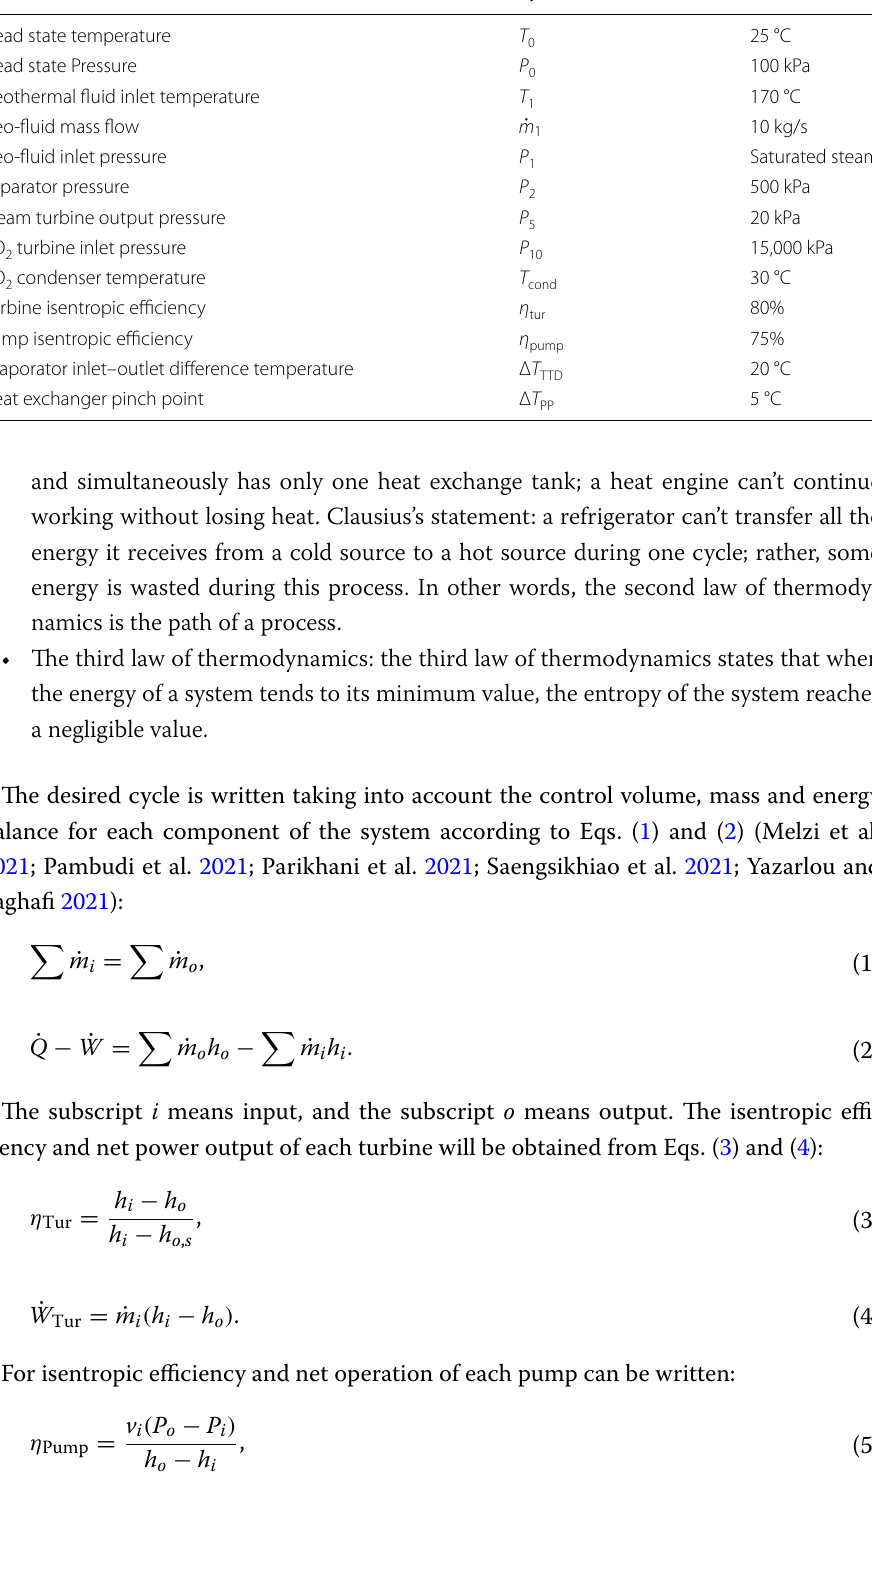
Table 1 Proposed system initial values (Wang et al. 2015) Parameter